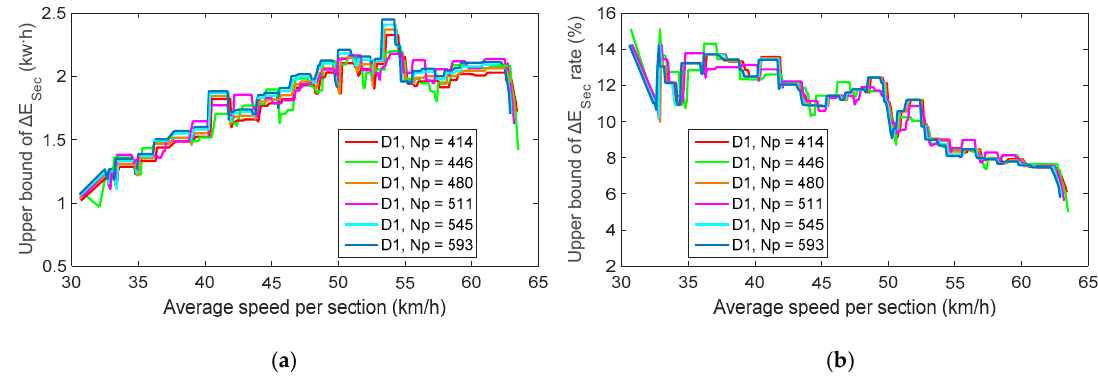
Figure 19. Comparison of upper boundaries with different N p values (weekday, TQ-SH). ( a ) ASS- REN-PLF boundaries; ( b ) ASS-RER-PLF boundaries.